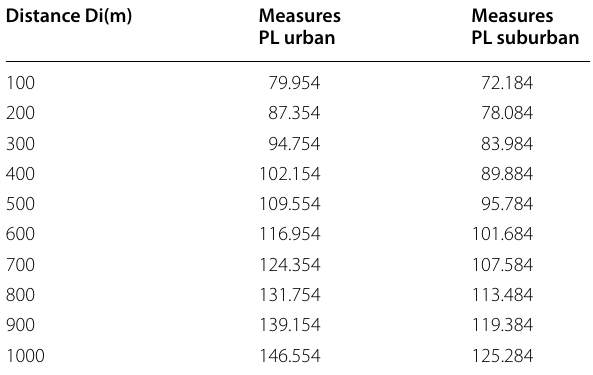
Table 4 Measured path loss for urban and suburban